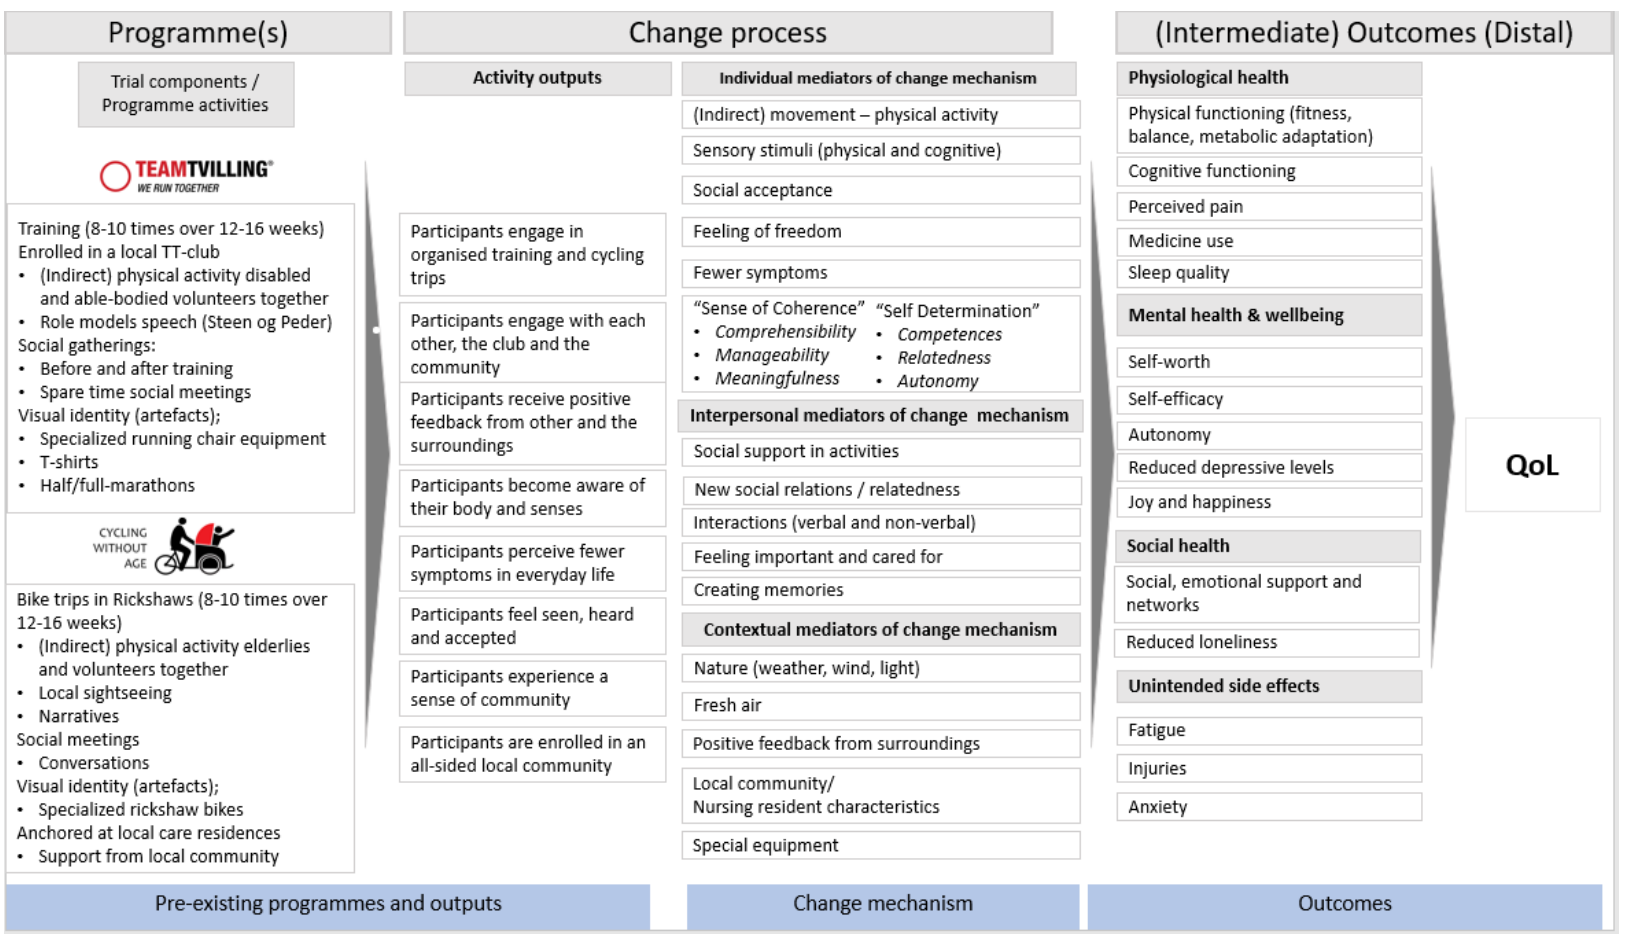
Figure 2. Programme theory overview incorporating both programmes and all target groups. N.B. some elements in the assumed “outcomes” and “change processes” do not count for both programmes and for all target groups.